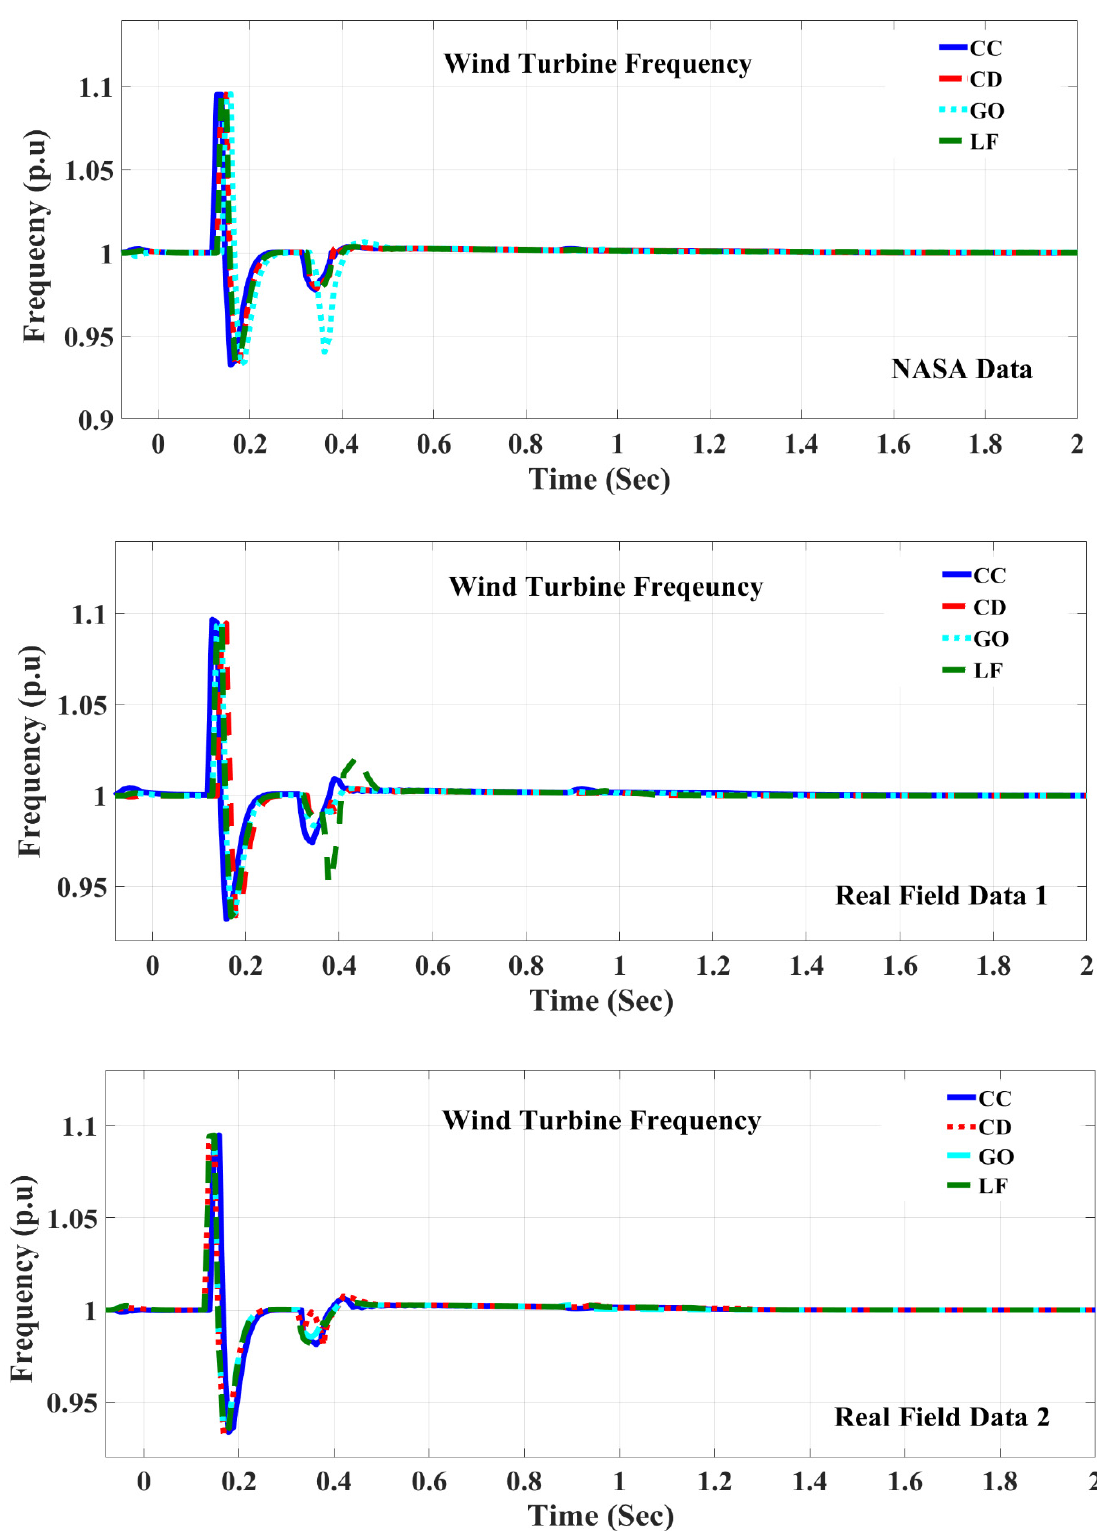
Figure 10. Frequency responses of wind turbine generator at Bus 1 for four dispatch strategies. The frequency responses of the CC and CD from PV module are very similar for all scenarios. However, for the GO and LF, they are very different for all scenarios. These frequency responses match with those of the wind turbine generator for Data Scenarios 1 and 2.